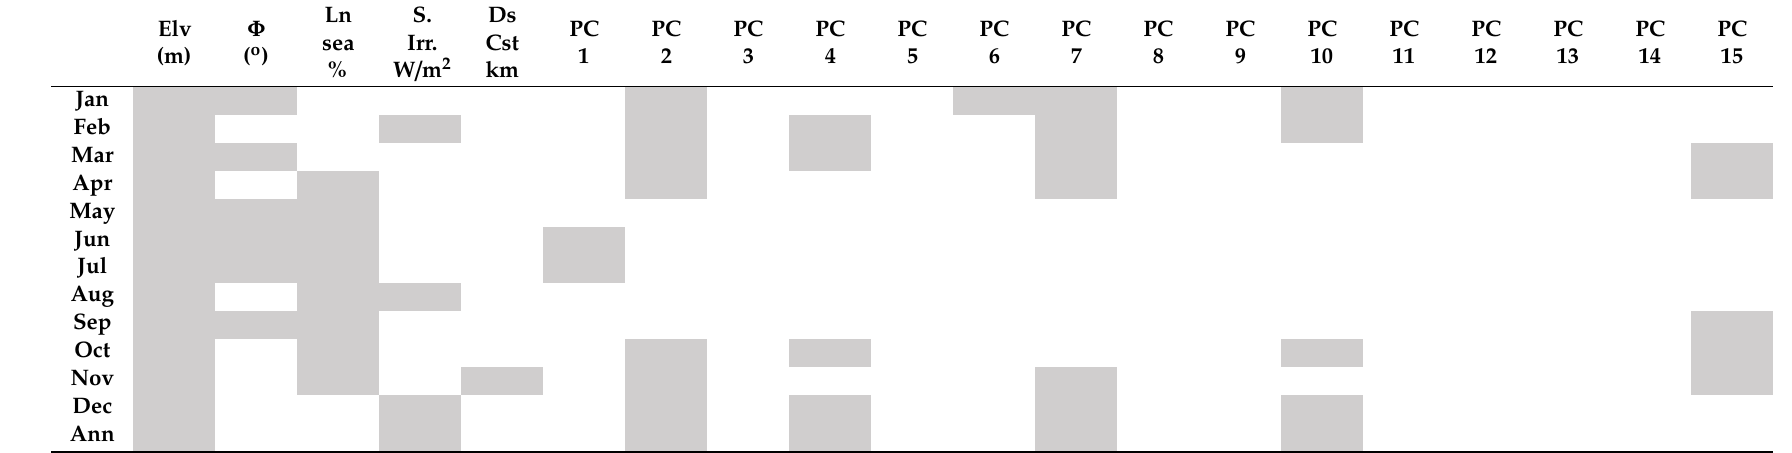
Table 1. Geophysical variables used as precipitation predictors (PC-1 to PC-15 correspond to the first fifteen principal components proposed by the AURELHY method). Φ Elv (m)